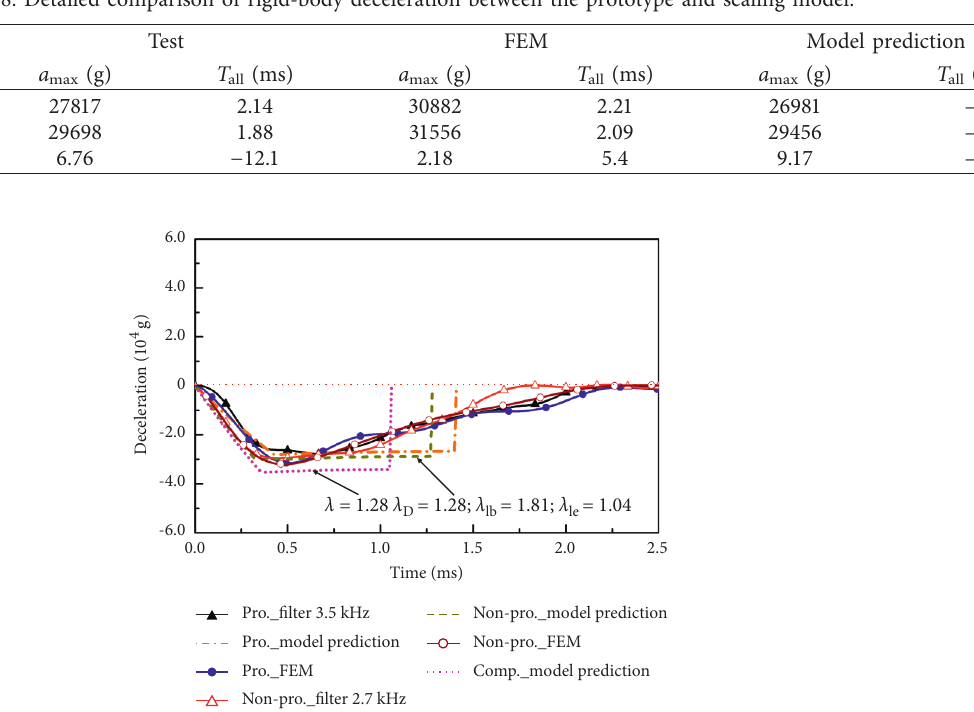
Figure 15: Rigid-body deceleration-time curves of the test, FEM, and empirical model for the prototype and nonproportional scaling